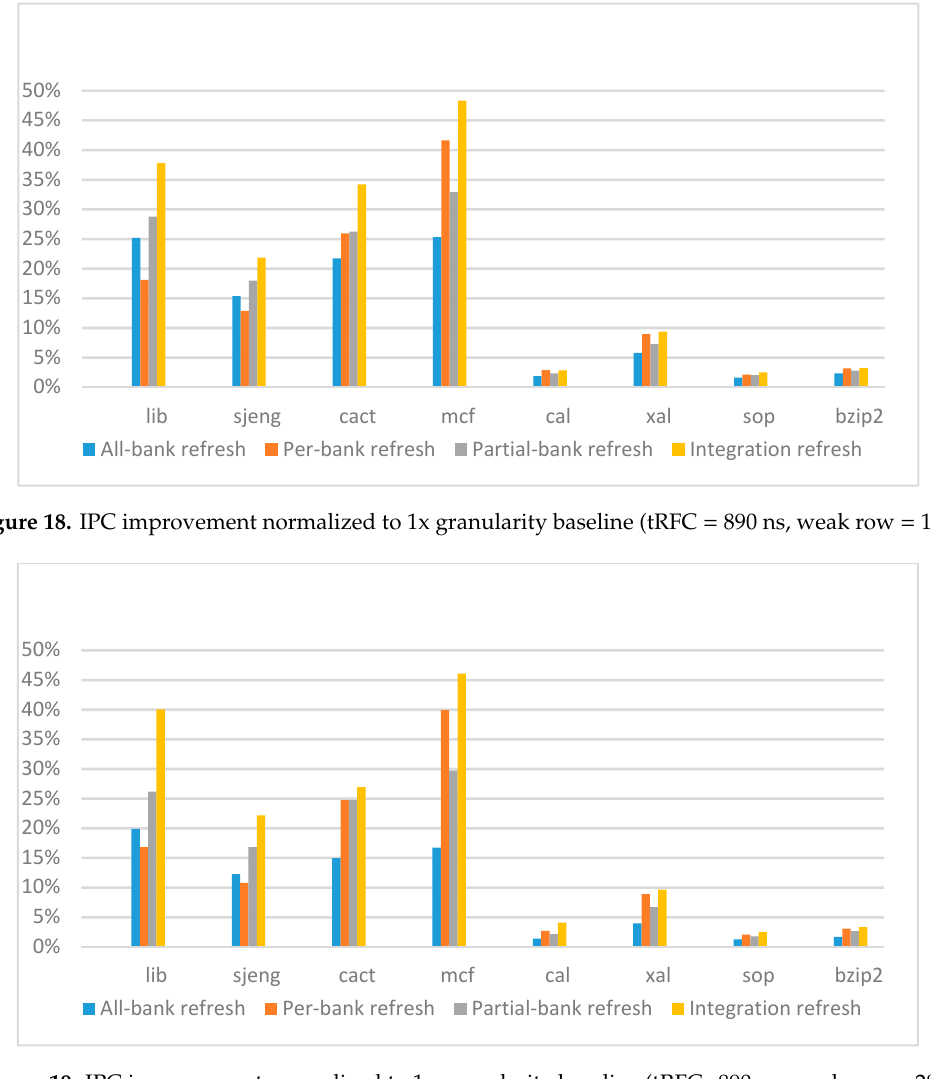
Figure 19. IPC improvement normalized to 1x granularity baseline (tRFC=890 ns, weak row = 2%).